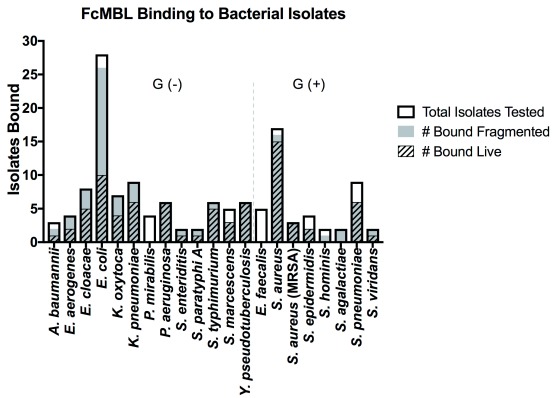
FcMBL binding to bacterial isolates is equal to or enhanced upon fragmentation.The graph is divided between Gram-negative bacterial isolates [Gram (-)] and Gram-positive bacterial isolates [Gram (+)]. Data are presented as the number of bacterial isolates bound live and fragmented within the total isolates tested for each species:
A. baumannii (
n = 3),
E. aerogenes (
n = 4),
E. cloacae (
n = 8),
E. coli (
n = 28),
K. oxytoca (
n = 7),
K. pneumoniae (
n = 9),
P. mirabilis (
n = 4),
P. aeruginosa (
n = 6),
S. enteriditis (
n = 2),
S. paratyphi A (
n = 2),
S. typhimurium (
n = 6),
S. marcescens (
n = 5),
Y. pseudotuberculosis (
n = 6),
E. faecalis (
n = 5),
S. aureus (
n = 17),
S. aureus (MRSA) (
n = 3),
S. epidermidis (
n = 4),
S. hominis (
n = 2),
S. agalactiae (
n = 2),
S. pneumoniae (
n = 9),
S. viridans (
n = 2).